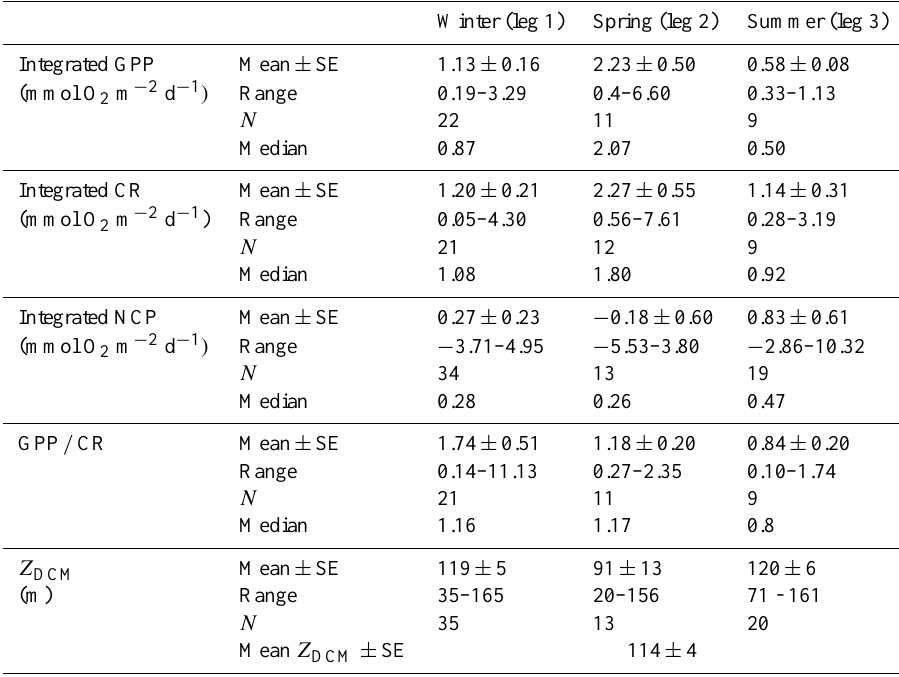
Table 2. Mean ( ± SE), range, number of observations ( N ) and median for the integrated metabolic rates (GPP, CR and NCP), GPP / CR ratio and the depth at which the DCM was located during each season.